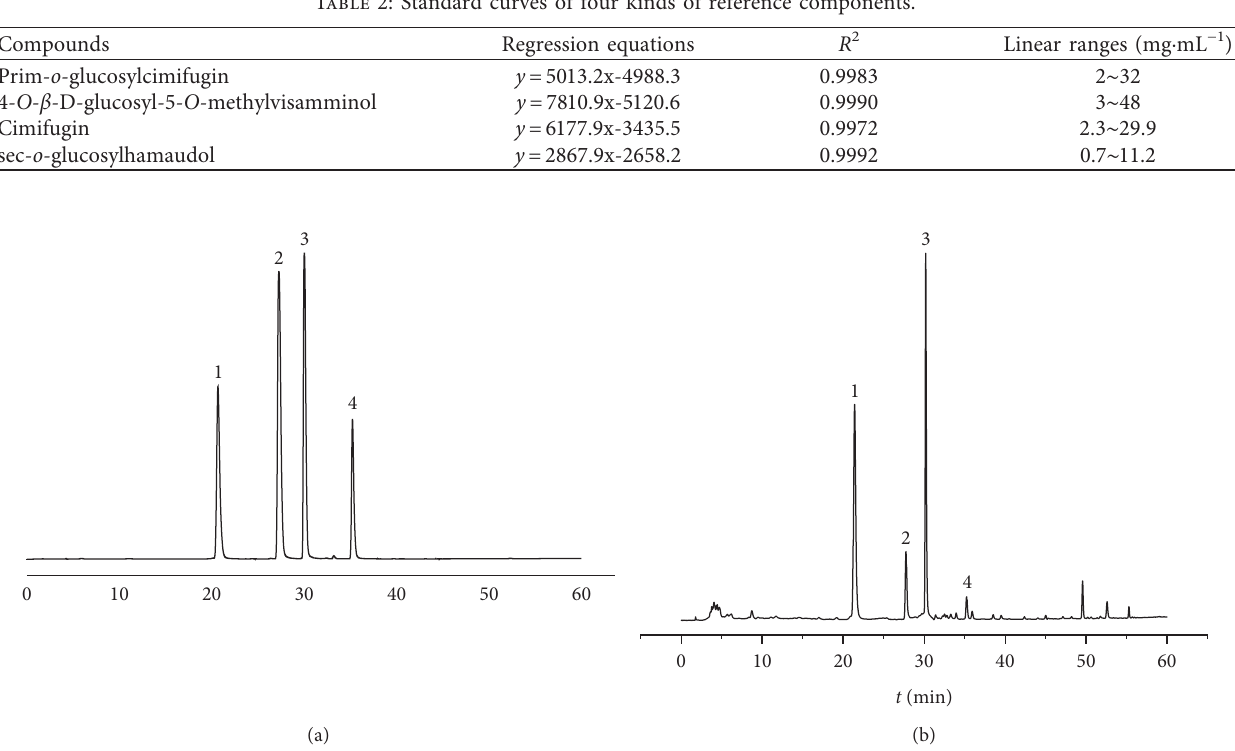
Table 2: Standard curves of four kinds of reference components.